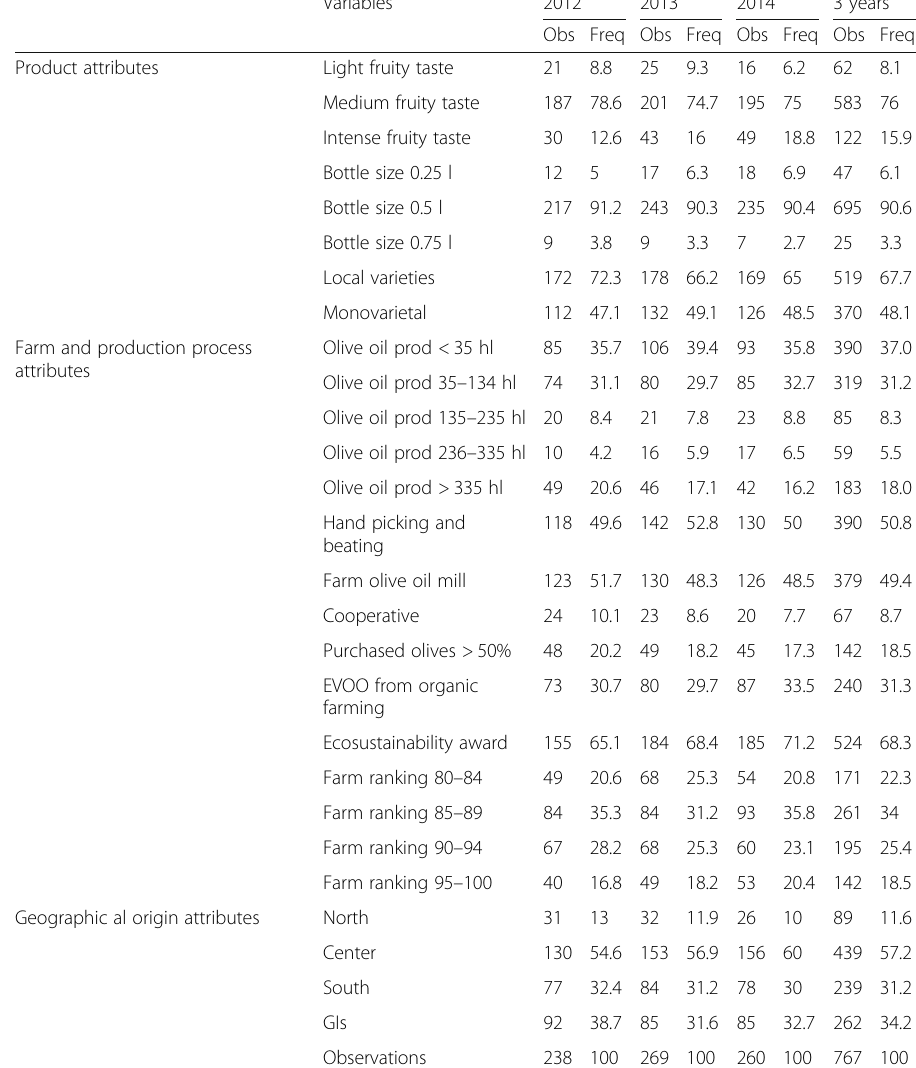
Table 2 Number of frequency of cases for the explanatory